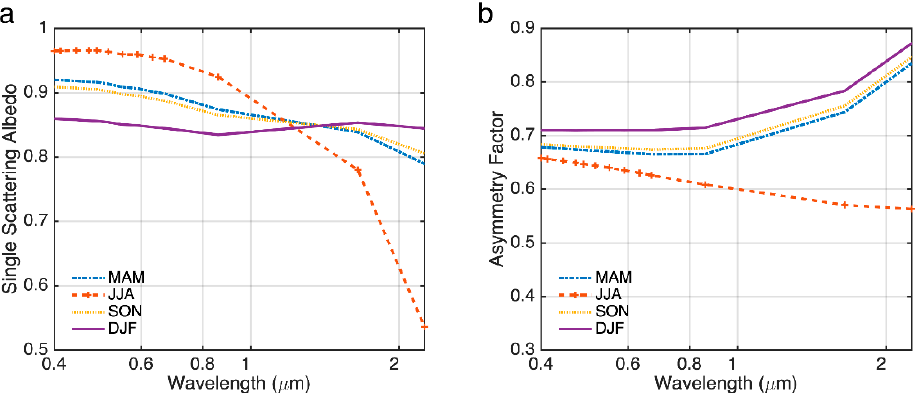
Figure12. Spectraldependenceofsinglescatteringalbedo( a )andasymmetryfactor( b )forreconstructed Figure 12. Spectral dependence of single scattering albedo ( a ) and asymmetry factor ( b ) for seasonal aerosol models at the Beijing-PKU reconstructed seasonal aerosol models at the Beijing-PKU site.